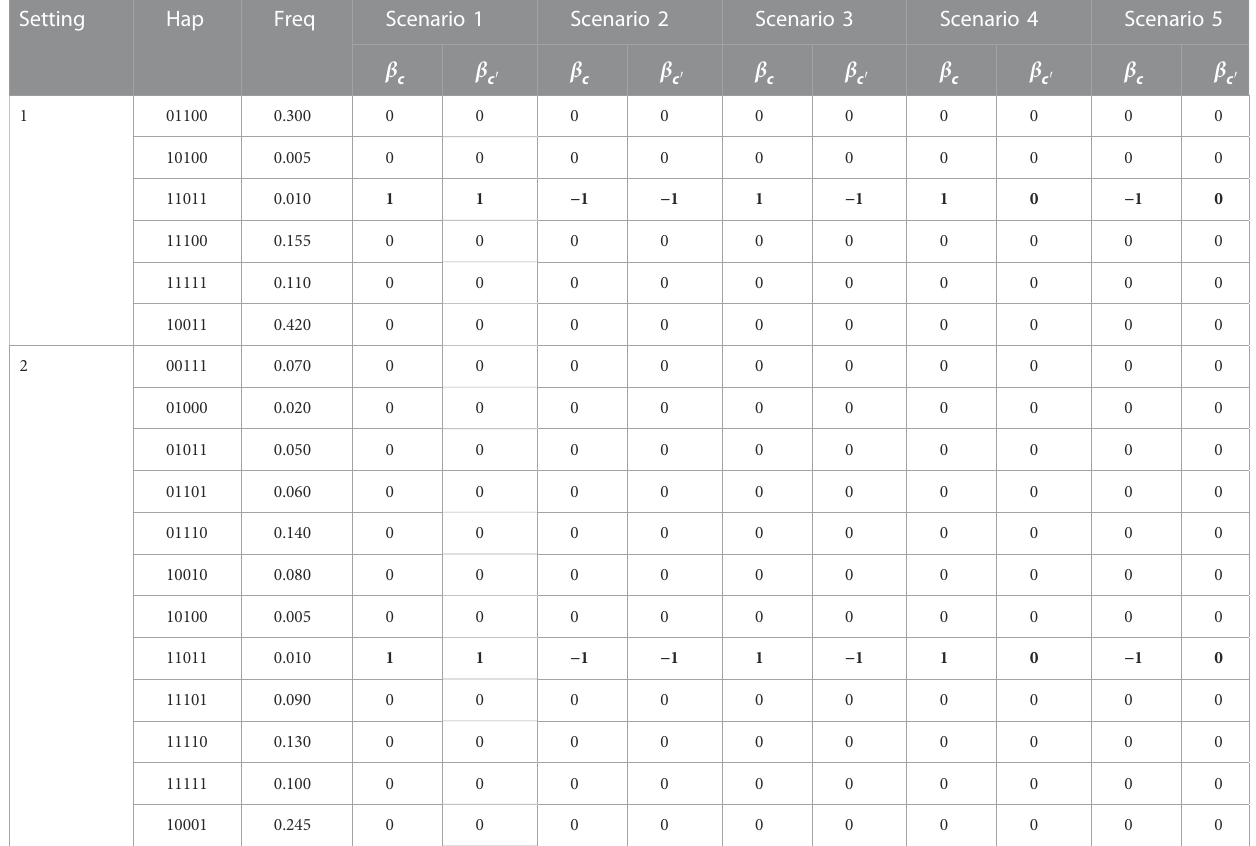
TABLE 1 Haplotype settings and association scenarios (the effect of target haplotype is shown in boldface).